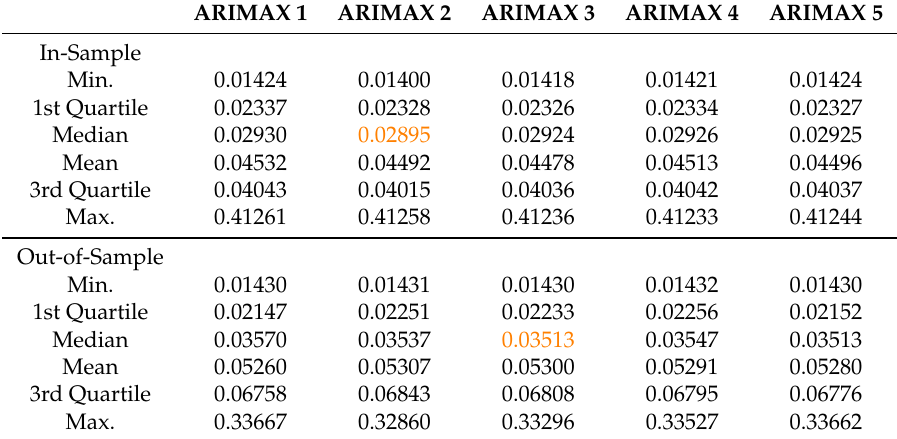
Table 8. Error distribution of ARIMAX models for in-sample and out-of-sample window of analysis of sovereign bonds issued by Germany. The highlighted data show the lowest Median RMSE over all